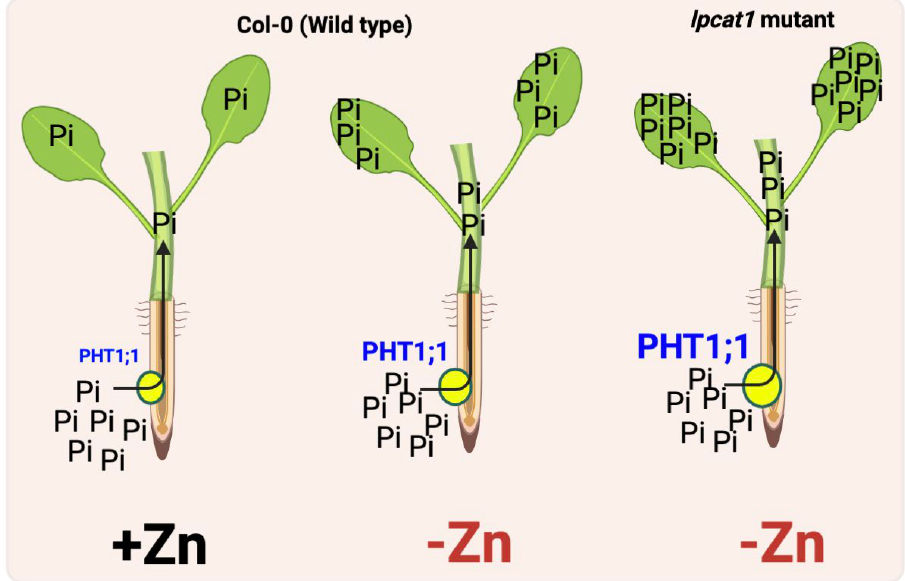
Figure 1. Schematic representation of signaling pathways controlling phosphate accumulation under zinc deficiency. In roots, phosphate (Pi) is acquired by high-affinity Pi transporters, PHT1;1. After following its radial transport, Pi is loaded into the xylem. Under −Zn conditions, the expression of PHT1;1 , Pi uptake, and translocation to shoots increases in wild-type plants, which are further enhanced in the Lysophosphatidylcholine (LPC) acyltransferase 1 ( LPCAT1 ) mutant background. LPCAT1 regulates the LPC:phosphatidylcholine (PC) ratio, which, in turn, increases the expression of the Pi transporter PHT1;1 , thereby resulting in the accumulation of Pi in shoots. Pi transfers to shoots, represented by a black arrow.